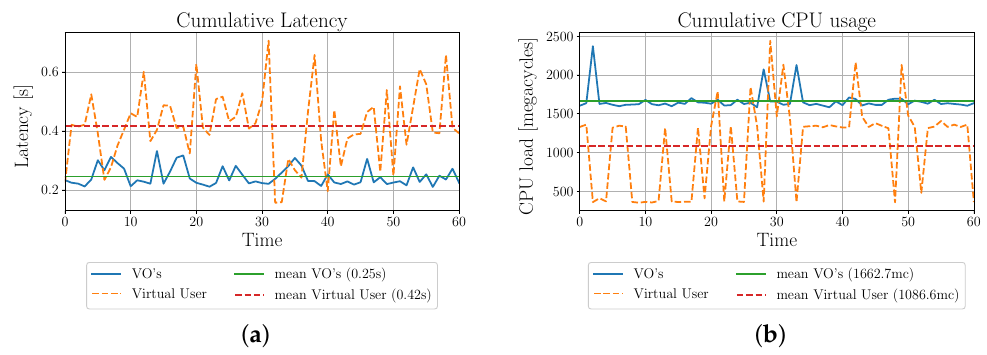
Figure 10. Comparison of latency and computational load for the VO-enabled and VU-enabled profiling. ( a ) Latency w.r.t. time; ( b ) CPU computational load w.r.t.